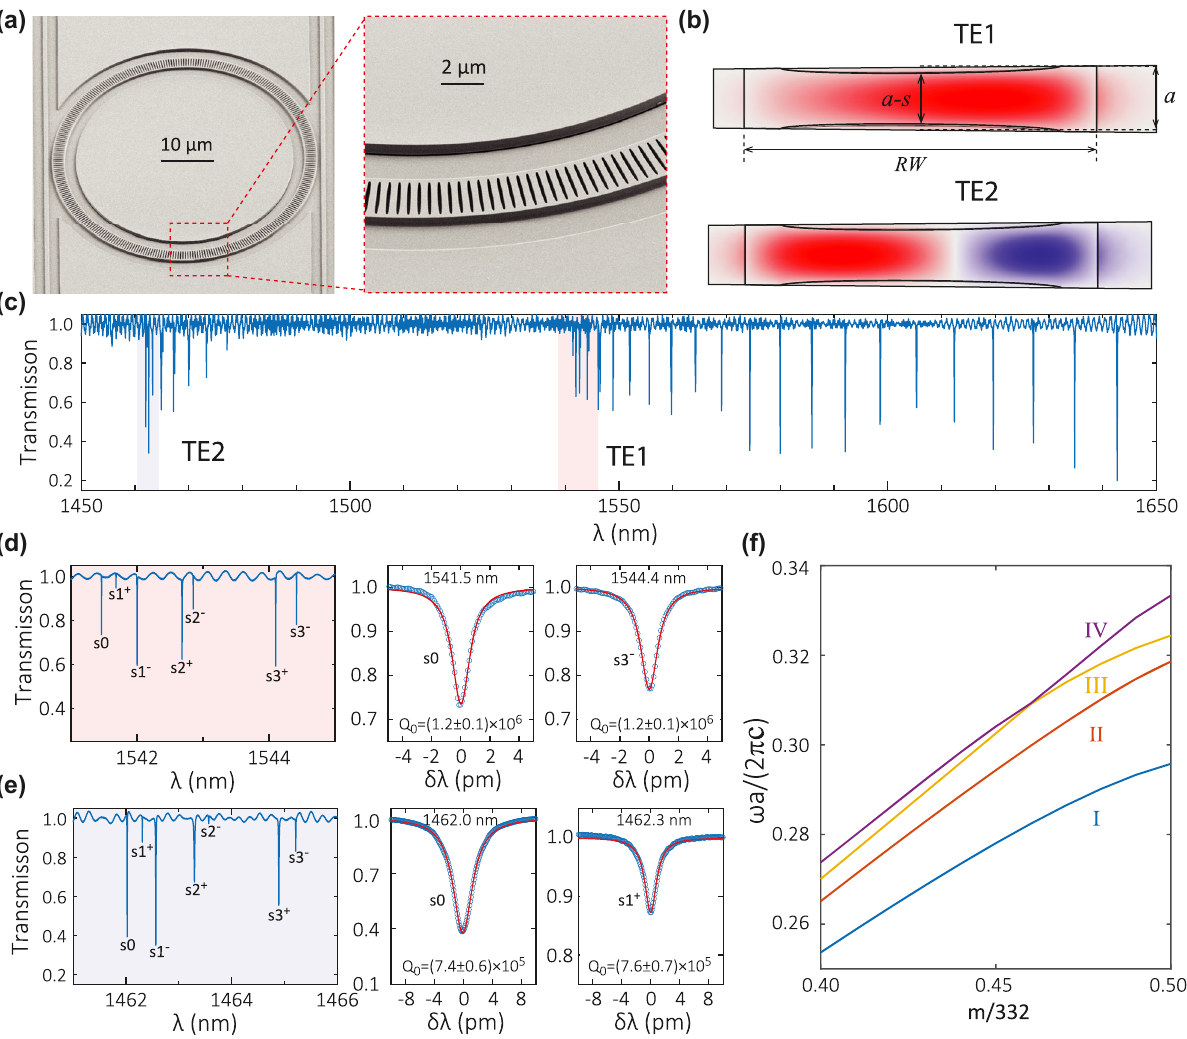
Figure 4: Introducing the “slit” photonic crystal ring (sPhCR). (a) SEM images of the sPhCR device and zoom-in view of the slit structure. The sPhCR has an outer ring radius of 25 μ m, a ring width of 2.5 μ m, and a thickness of H = 500 nm. There are 332 identical cells in this sPhCR with a period of a = 450 nm. Each cell has an elliptical air slit that is 2 μ m long and s = 90 nm wide. (b) A finite-element-method simulation of a unit cell of the sPhCR device, showing the dominant (radial direction) electric field profiles of the fundamental and 2nd-order band-edge modes in top view, labeled as TE1 is 6 × 10 6 and 1 × 10 6 for the s 0 modes of TE1 and TE2, respectively. (c) Measured transmission spectrum of the and TE2, respectively. The simulated Q 0 sPhCR device showing two sets of dielectric band modes. (d) and (e) The modes at the TE1 and TE2 dielectric band-edge (pale red shaded areas) are zoomed-in and displayed in the middle panel, labeled as { s 0 , s 1 ± , s 2 ± , s 3 ± } . The right panels show nonlinear least squares fits to the s 0 and s 3 − / s 1 + modes, respectively. The uncertainty in Q represents the 95% confidence range of the nonlinear fits. (f) The first four dielectric bands simulated by the 0 MIT photonic bands software package [45]. The blue and red curves at m /322 = 0.50 (i.e., m = 161) correspond to TE1 and TE2, respectively, as shown in (b). The y -axis is in units of normalized frequency, where c is the speed of